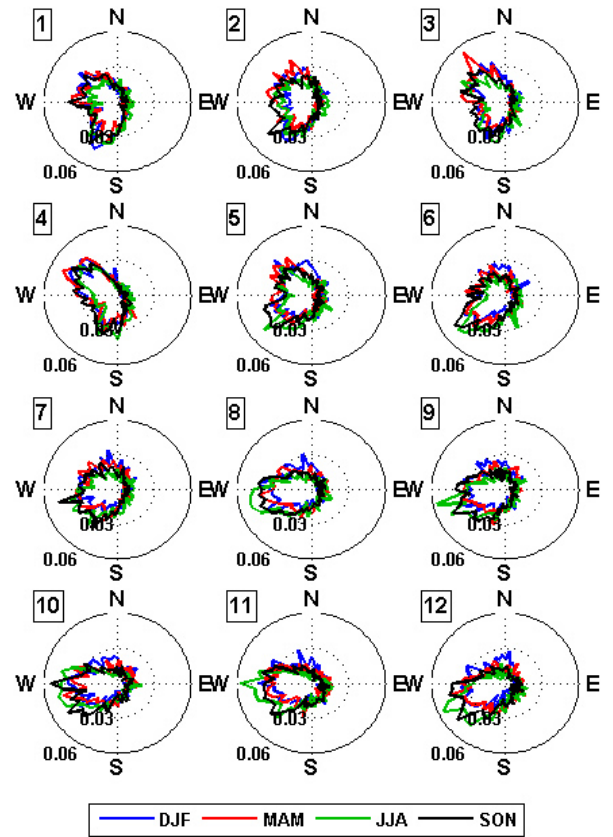
Figure 8. Distribution of wind direction at 850hPa at the 12 radar stations during different seasons based on the daily data from ERA- Interim reanalysis. The PDFs were computed for the same time pe- riod as that of radar data (i.e.